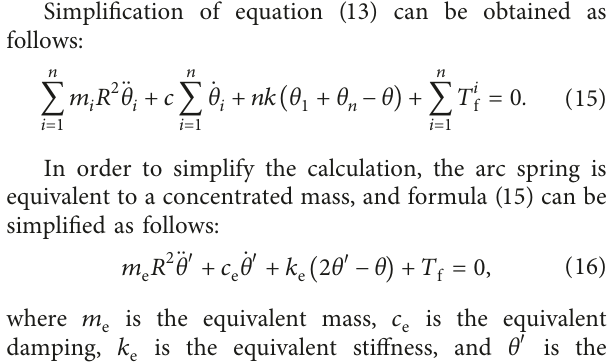
Figure 7: DMF simplified